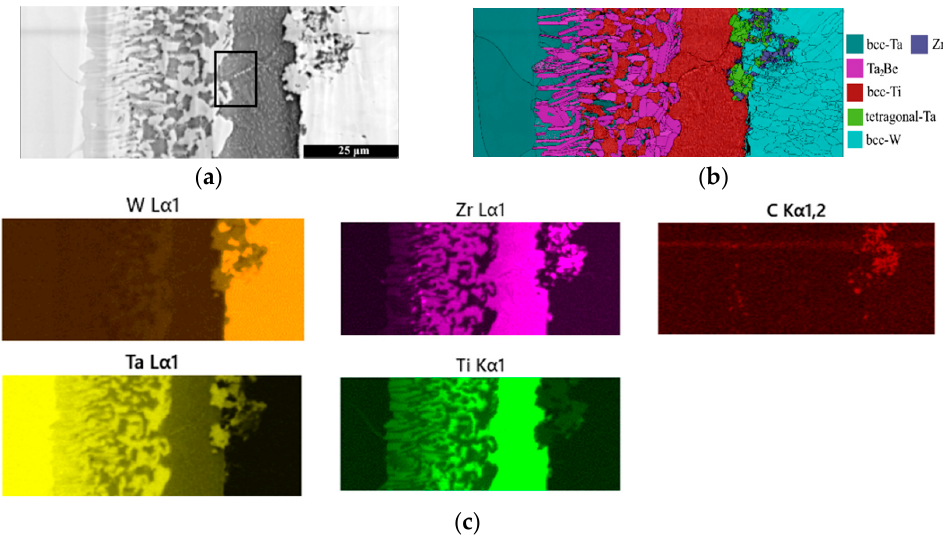
Figure 8. SEM analysis of Ta/TiZr4Be/W seam: ( a ) backscattered electron image; ( b ) EBSD phase map; ( c ) EDS distribution maps.